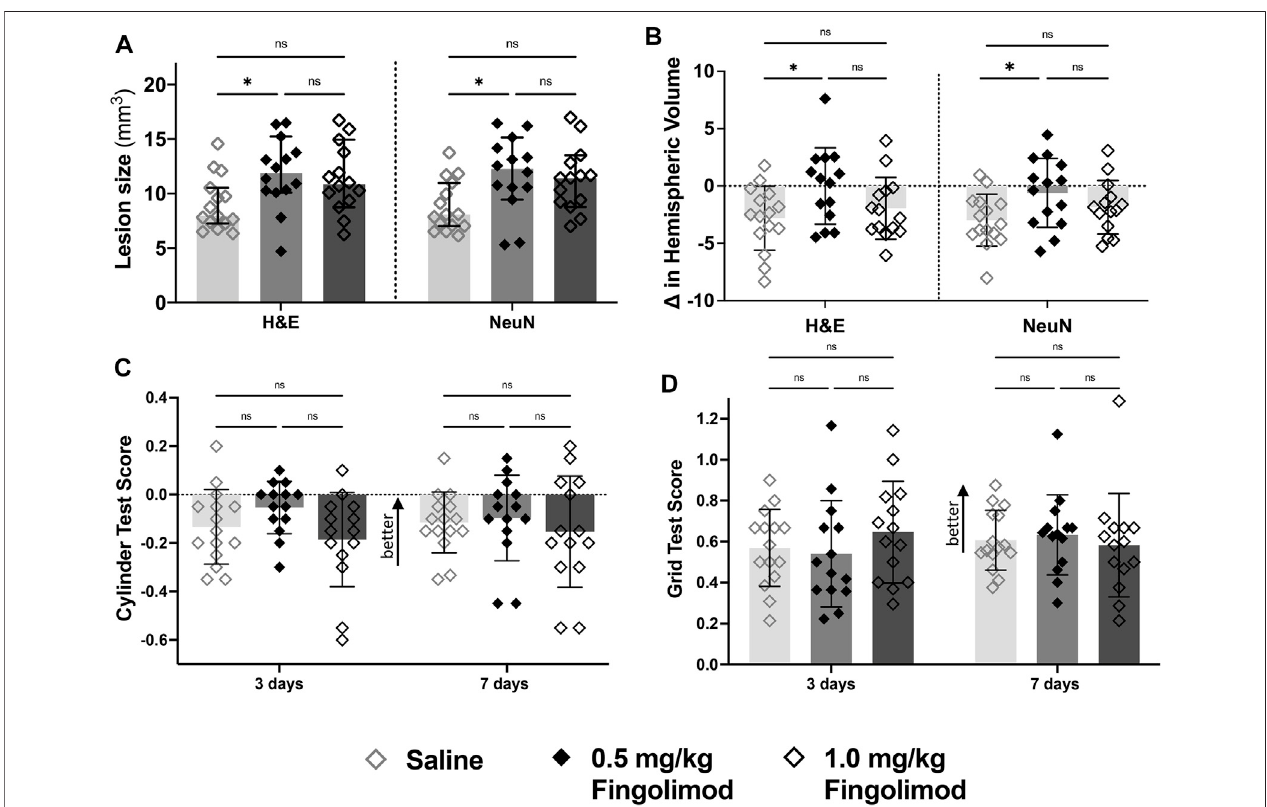
FIGURE2| Doseresponse study — (A) Lesion sizemeasurements, bystainingmethod; saline-treated mice hadasmallerlesion size7 daysafter stroke compared tothe0.5 mg/kgdoseforbothstainingmethods. (B) Differenceinvolumebetweenbrainhemispheres;saline-treatedmicehadasigni fi cantreductioninthehemispheric volume(L-R/SUM)compared tothe0.5 mg/kggroup. (C) Cylindertestresultsat3-and7-dayspost-stroke(negativescoresrepresentpreferencefortheleftpawusage (ipsilateral)); there was no difference in scores over time. (D) Grid walking test scores (scores closer to 1 represent a more comparable number of missed steps on each side); there was no difference over time or between treatment groups ◇ Saline ( n = 15) ◆ 0.5 mg/kg fi ngolimod ( n = 14) ◇ 1.0 mg/kg fi ngolimod ( n = 14). Mean ± SD; ns - not signi fi cant; * p <